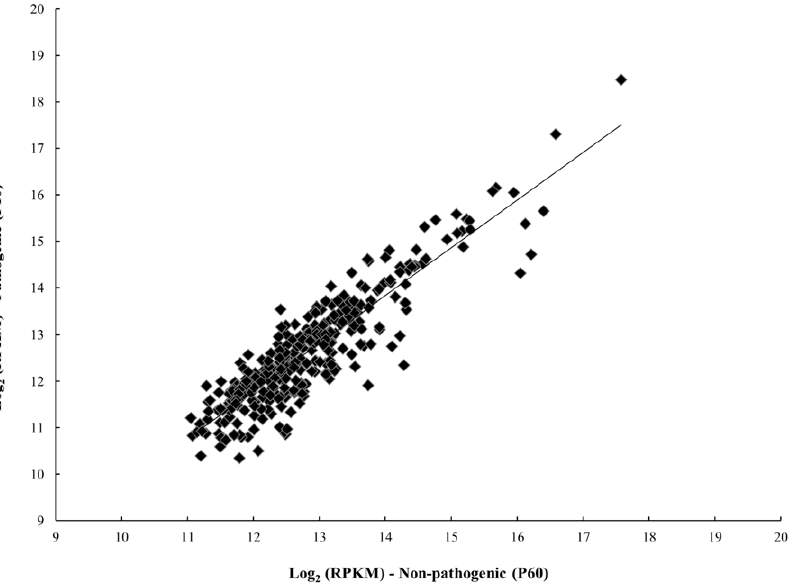
Figure 3. Average log-transformed RPKM (log 2 [RPKM]) of the 319 genes commonly expressed by the pathogenic (y-axis) and non- pathogenic (x-axis) variant. The trend line represent a linear regression model ( p -value , 0.05; r 2 =0.809).